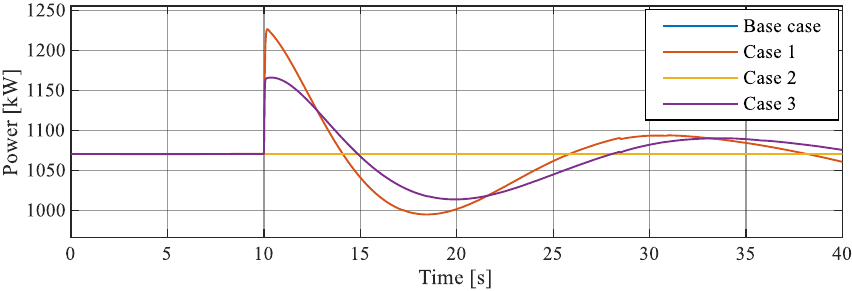
Figure 13. Active power delivered by the three wind turbines when a sub-frequency event occurs.